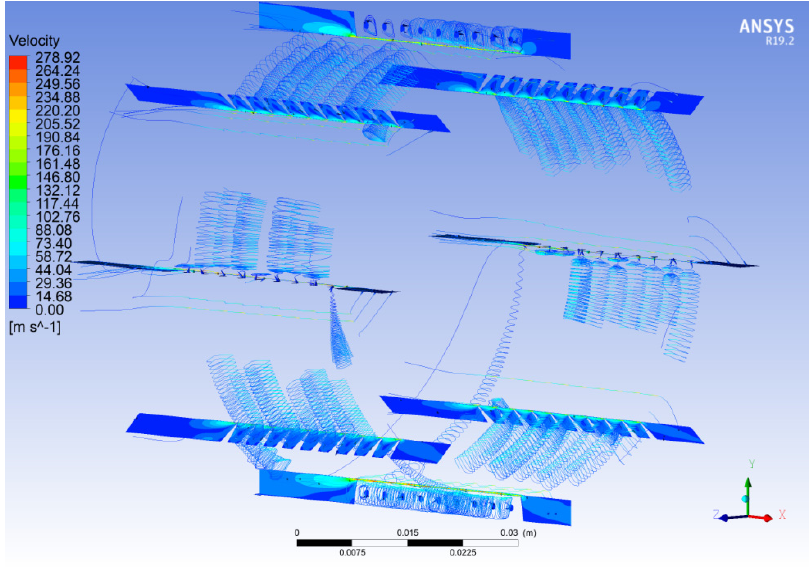
ω Ω ω = 5000 rpm, = 50 Hz). Ω = 5000 rpm, = 50